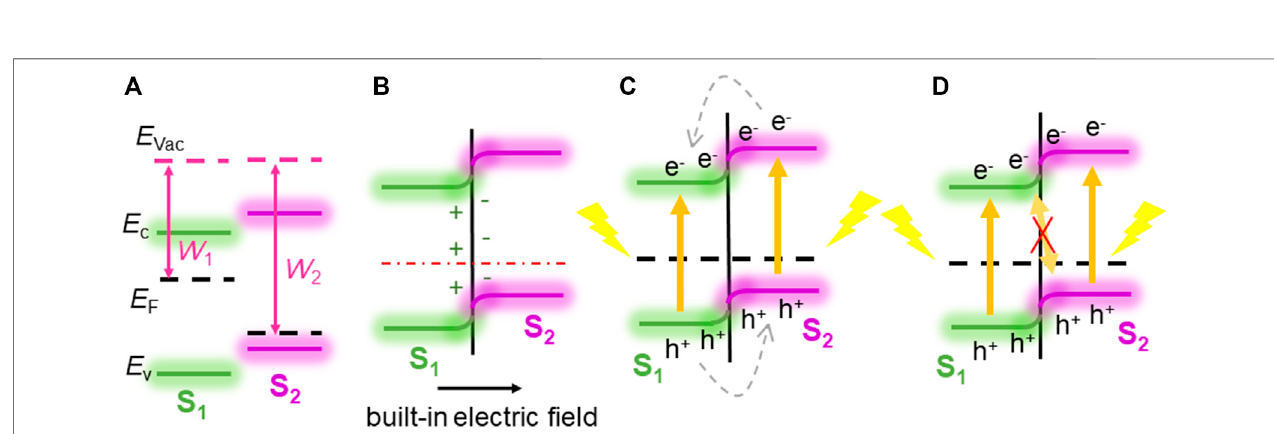
FIGURE4| ThedirectZ-schememechanismdemonstrationforCdO/AsvdWheterostructure: (A) beforecombining, (B) incombining; (C – E) photoinducedcharge carrier migration process.